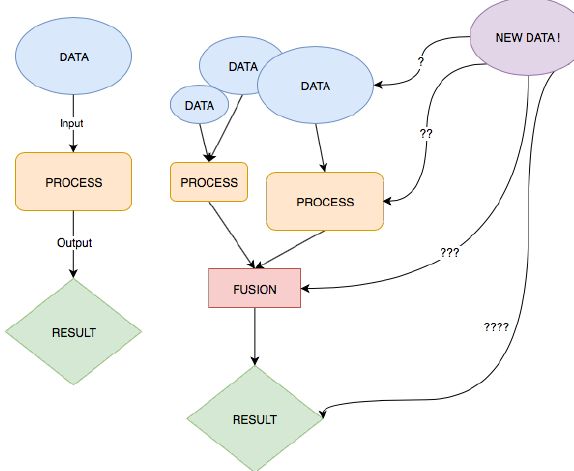
Figure 2: Proposed approach of automated incremental process- ing powered by TACO for the CH dedicated tool AIOLI straints, progressively released to gain in robustness (and pro- portionally increasing uncertainty) with rebellious or sub-optimal dataset, the main drawback being the time of computation (com- pensated with our computation server